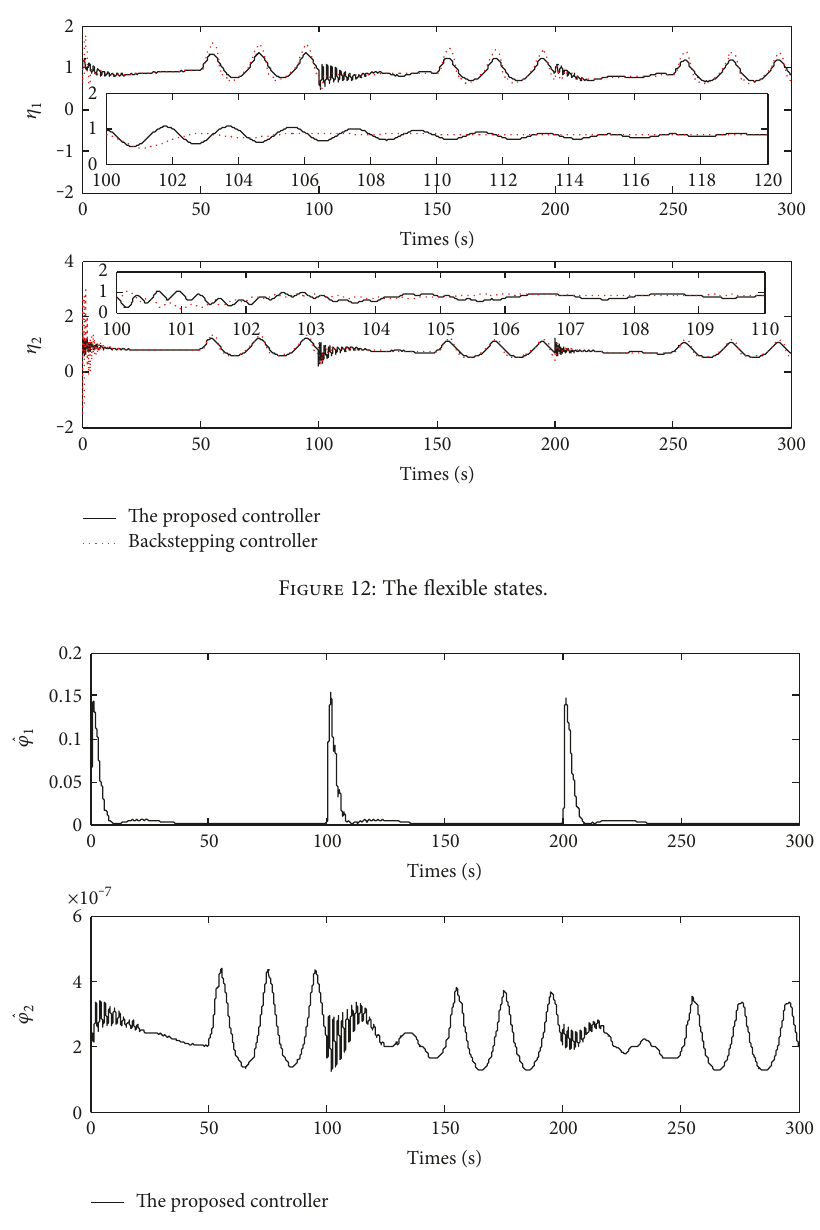
Figure 13: The estimations of φ